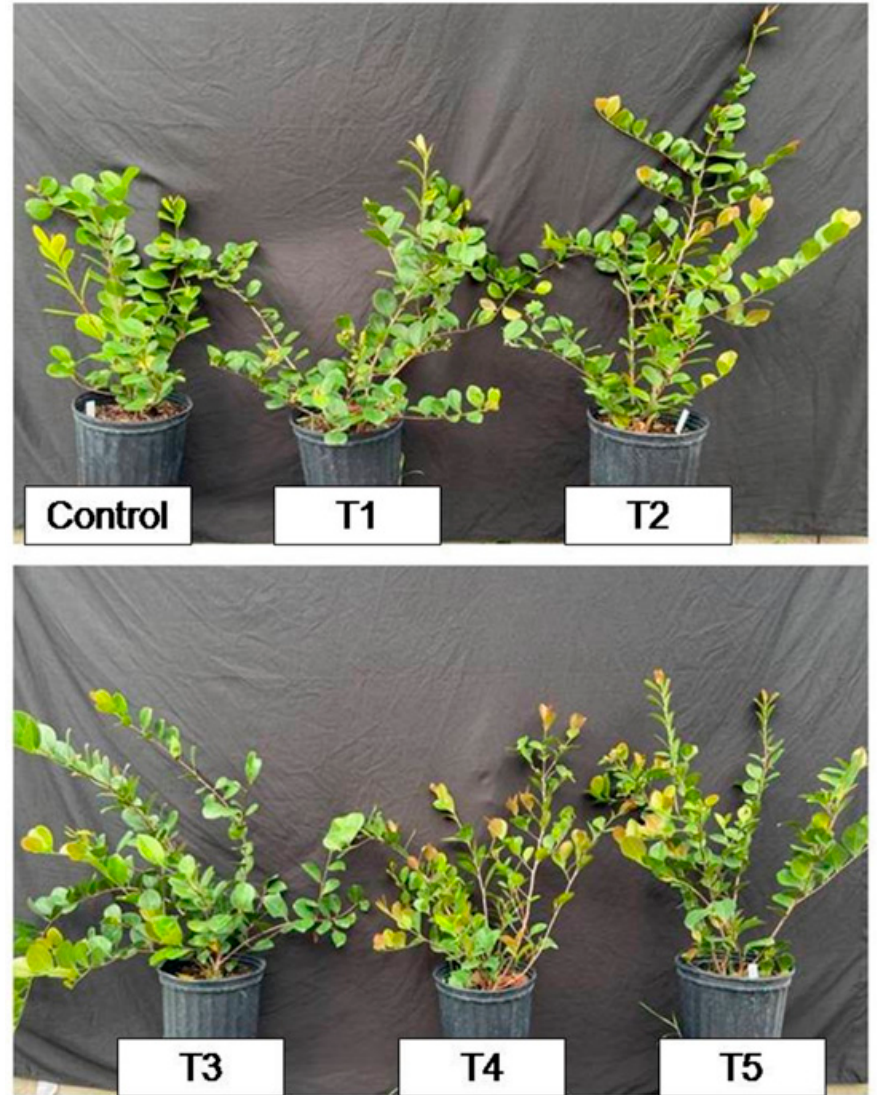
Figure 3. Cocoplum grown in different fertilization rate at the end of the experiment at six months (180 days after fertilization). 15 g (control), 15 g (supplemented with +15 g applied 2 times in November and March; T1), 15 g (+15 g November; T2), 30 g (+15 g November and March; T3), 30 g (+15 g November; T4), and 45 g (+15 g November and March; T5). Table 6. Correlation coefficient ( r ) for measured sensor parameters, number of leaves (NL), and total nitrogen (TN) and total carbon (TC) of leaf samples in cocoplum at 30, 60, 90, 120, 150, and 180 days after fertilization (DAF). atLEAF NDVI TN (%) TC